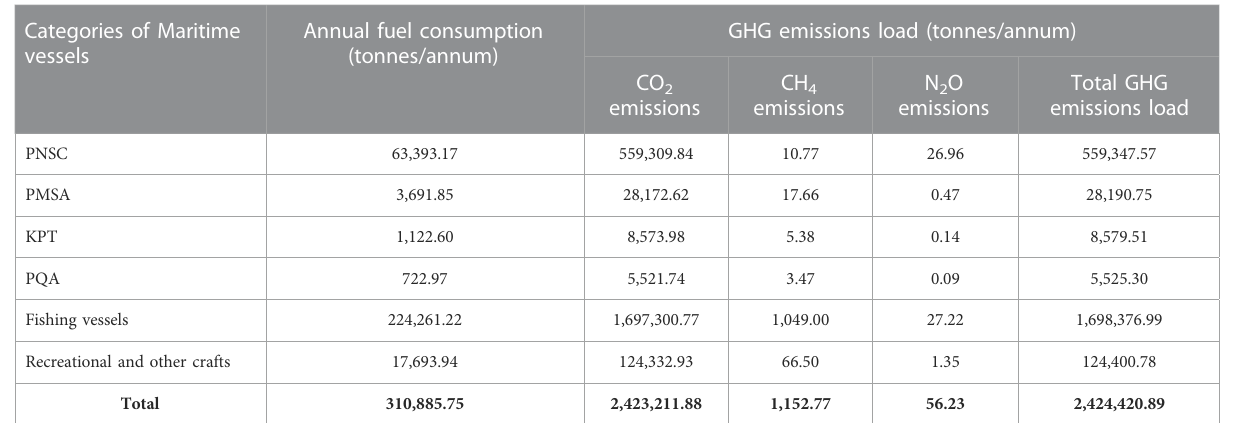
TABLE 7 Total GHG emissions load from each category of maritime